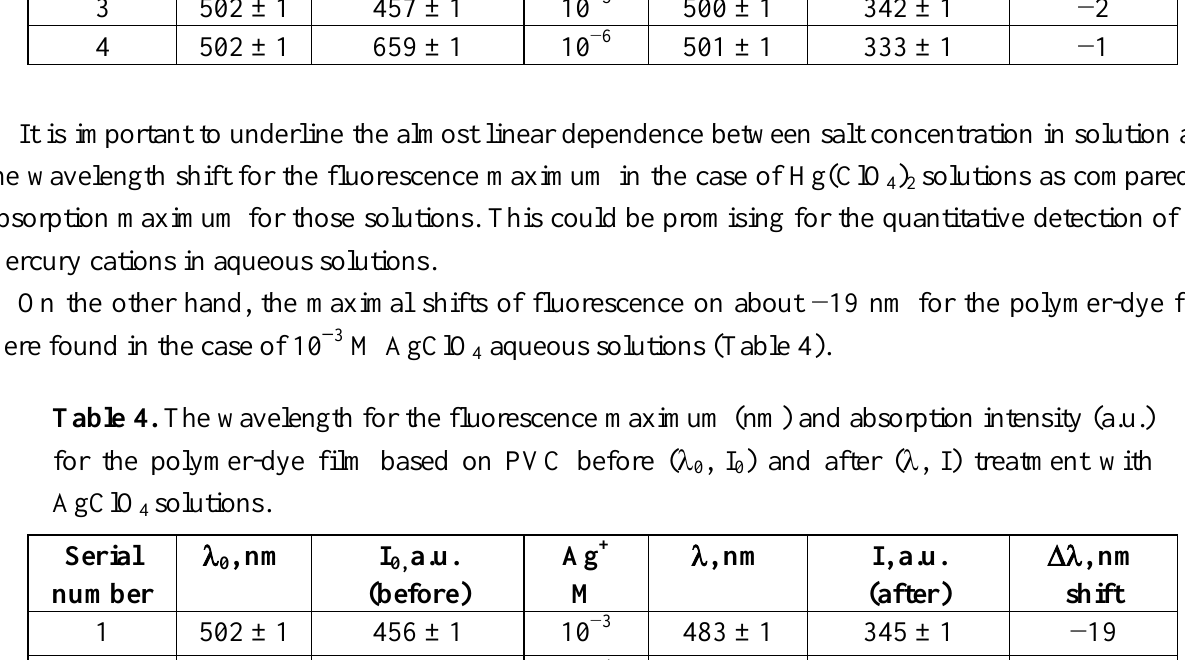
, I ) and after (  , I) treatment with 0 0